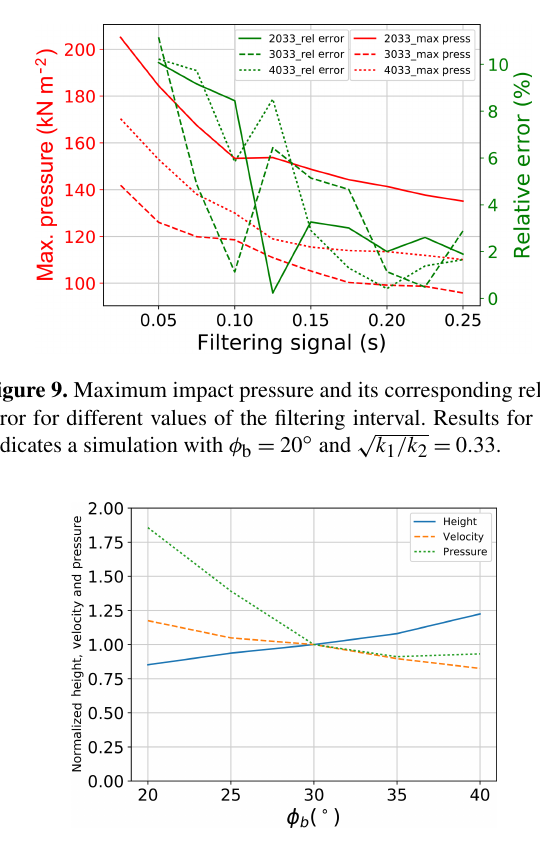
Figure 10. Variation in flow height, velocity and pressure for differ- ent values of basal friction angle ( φ b ) when normalized by results √ k 1 /k 2 = 0 . 3, d 50 = 75mm and of the simulation with φ b = 30 ◦ , α = 30 ◦